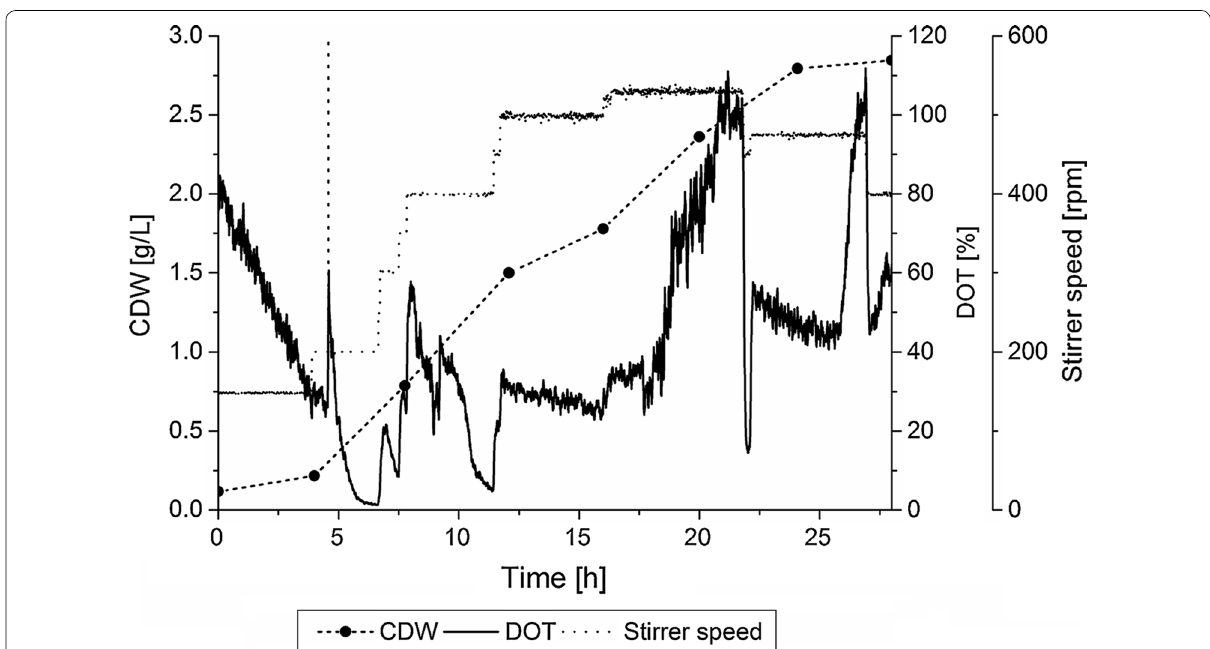
Fig. 2 Batch fermentation of S. cerevisiae in a KLF2000 fermenter (working volume 1.8 L), using glucose as a carbon source with an unregulated pH in SD medium. Stirring rate was controlled manually to find constant aeration parameter without limitations and without influences on the exhaust gas. Cell dry weight concentrations, DOT and stirring rate are